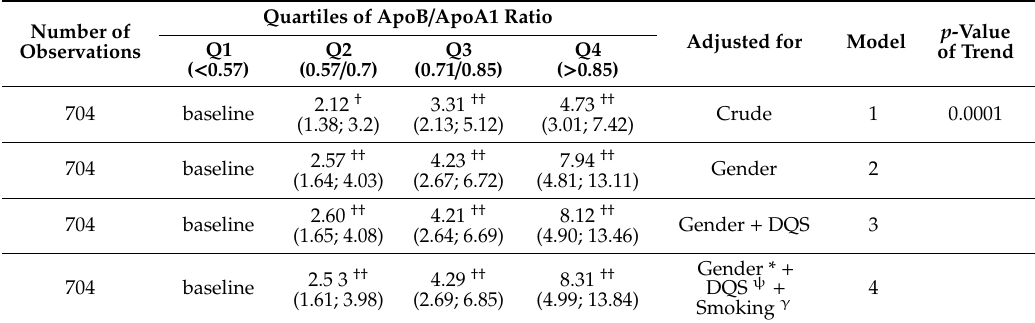
Table 3. Crude and adjusted odds ratios (ORs) of metabolic syndrome (MS) for 25, 50, 75% quartiles of the ApoB / ApoA1 ratio.